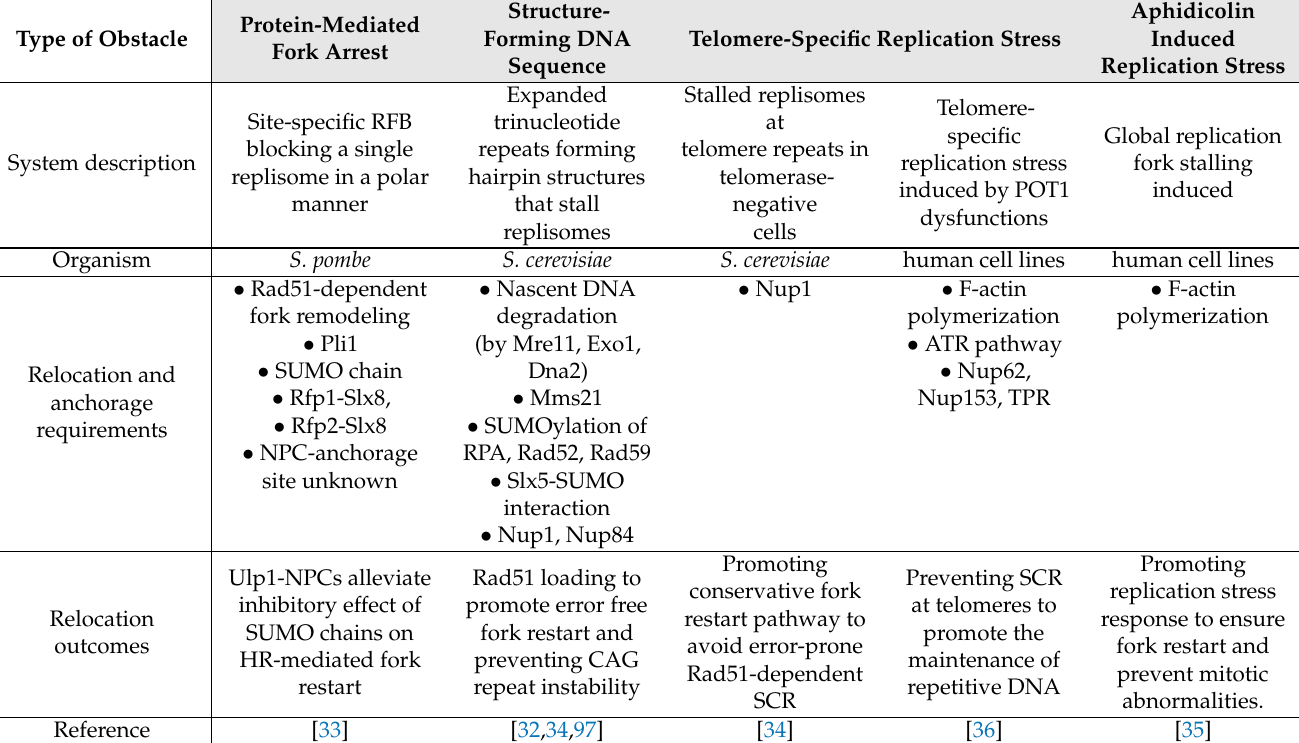
Table 2. Comparison of systems of replication stress relocation to NPC/nuclear